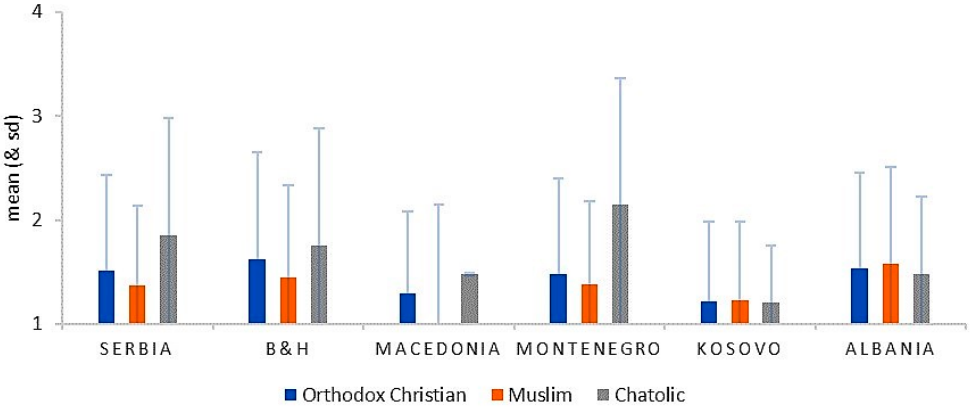
Figure 19. Accepting/giving a bribe by confession and country. (The error bars represent standard deviation).